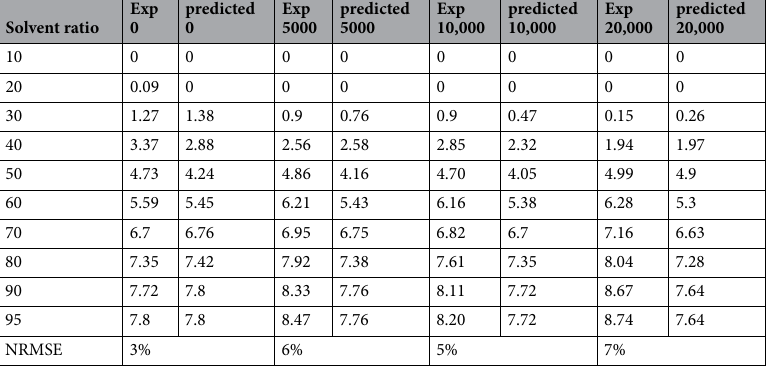
Table 6. Comparison of experimental and predicted asphaltene precipitation—Crude oil sample B (NRMSE = 5.2%).